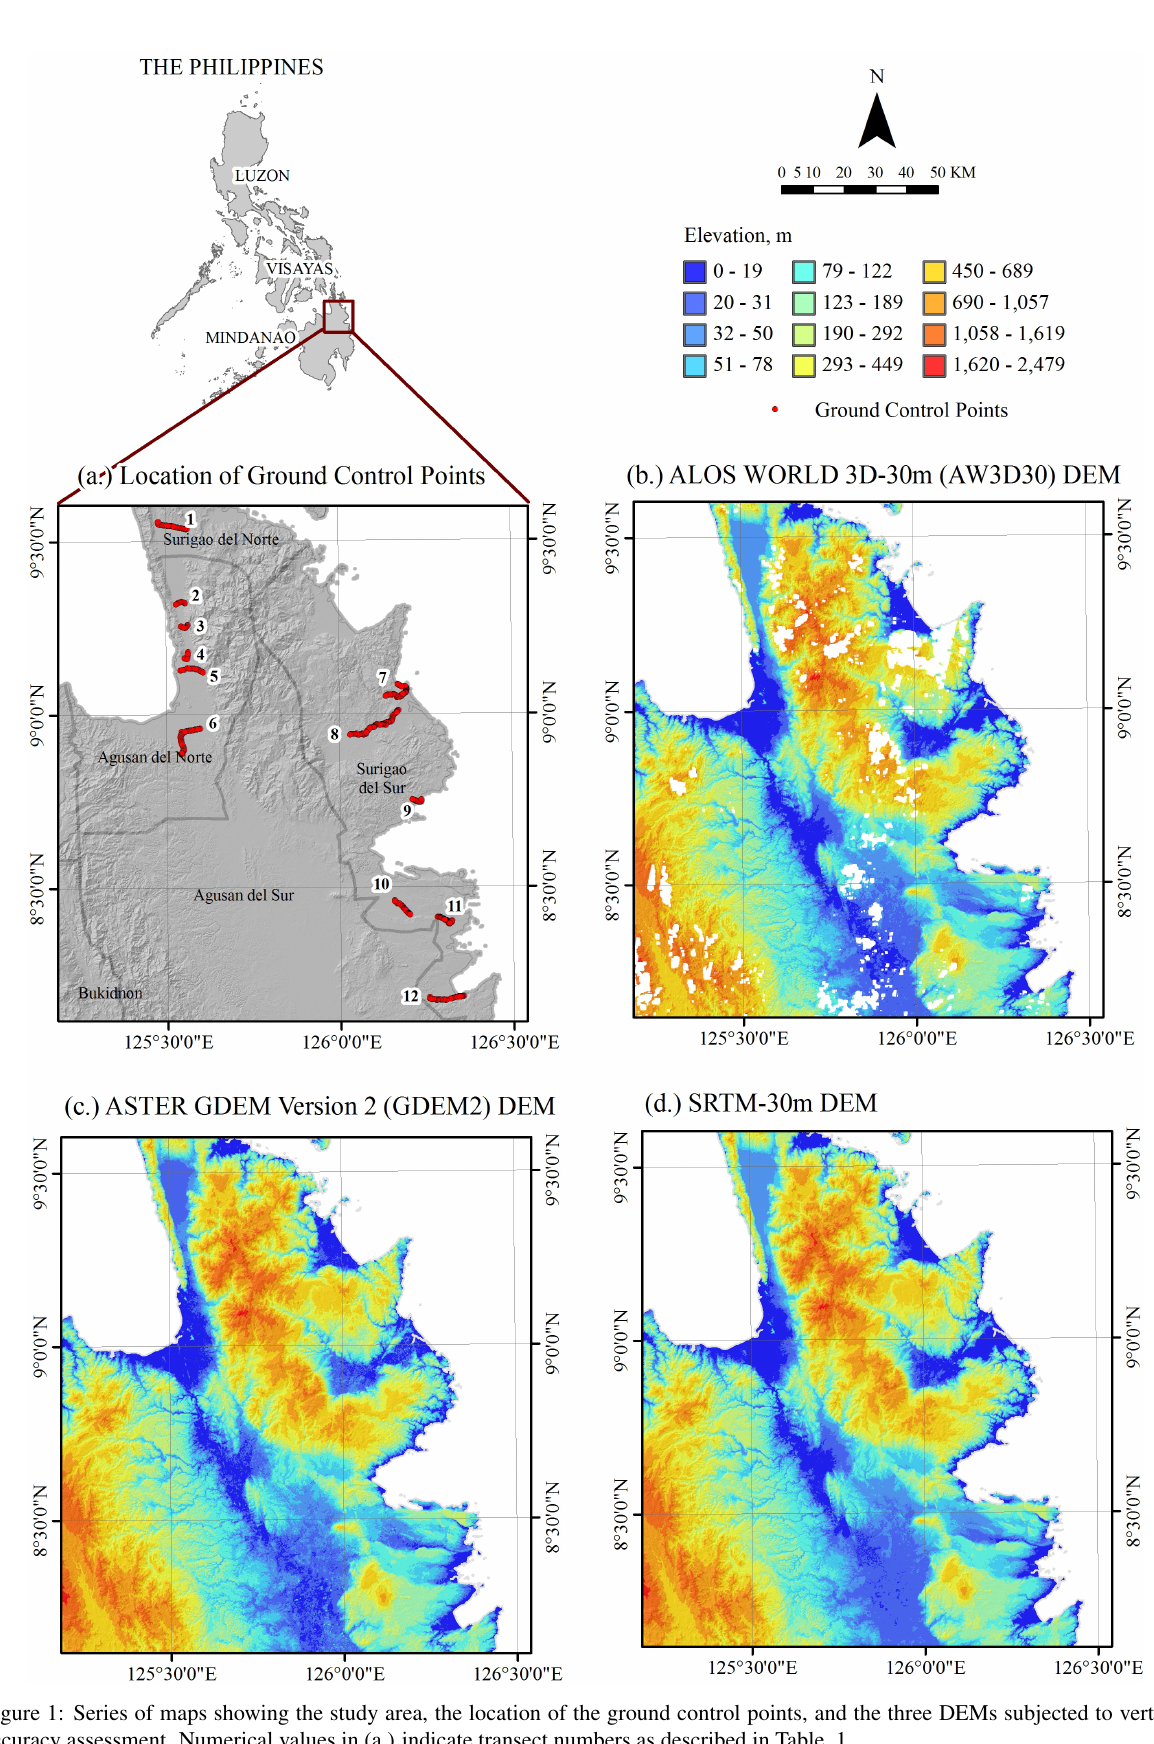
Figure 1: Series of maps showing the study area, the location of the ground control points, and the three DEMs subjected to vertical accuracy assessment. Numerical values in (a.) indicate transect numbers as described in Table